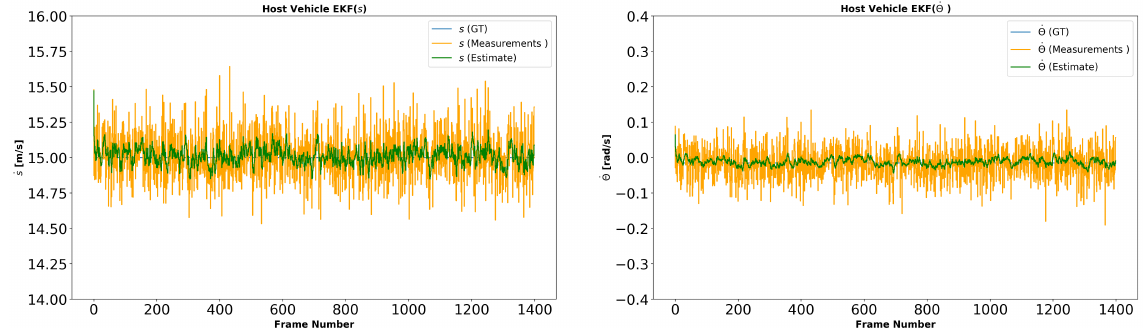
Figure 4. Experiment II (velocity estimation in simulation) results. Left: ˙ s is the linear velocity of the host vehicle. Right: ˙ θ is the angular velocity of the host vehicle. Ground truth is a constant 15 m/s and − 0.01 rad/s. Green lines show estimated values from the proposed model. Orange lines are the noisy observations. The filter is effective at smoothing the velocity of the host